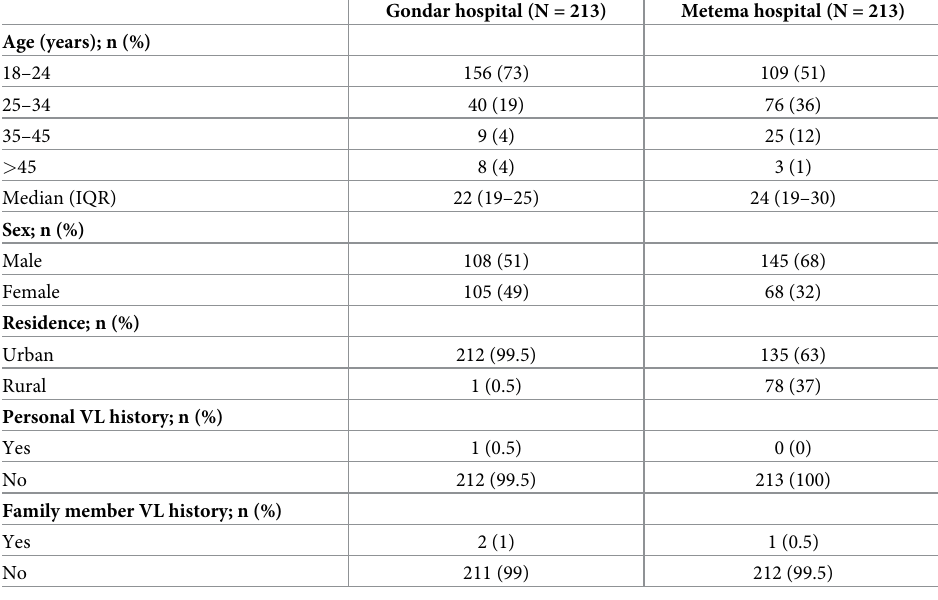
Table 1. Baseline characteristics of blood donors at two sites in northwest Ethiopia, 2020.